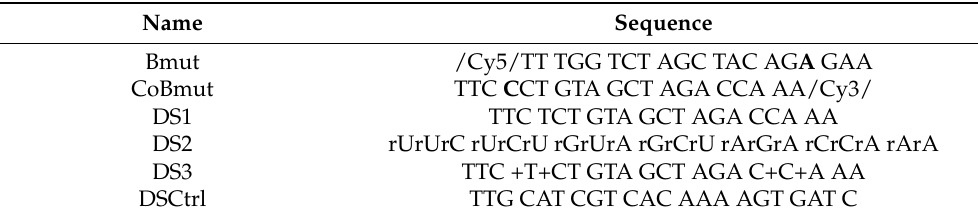
Table 1. Oligonucleotide sequences used in this